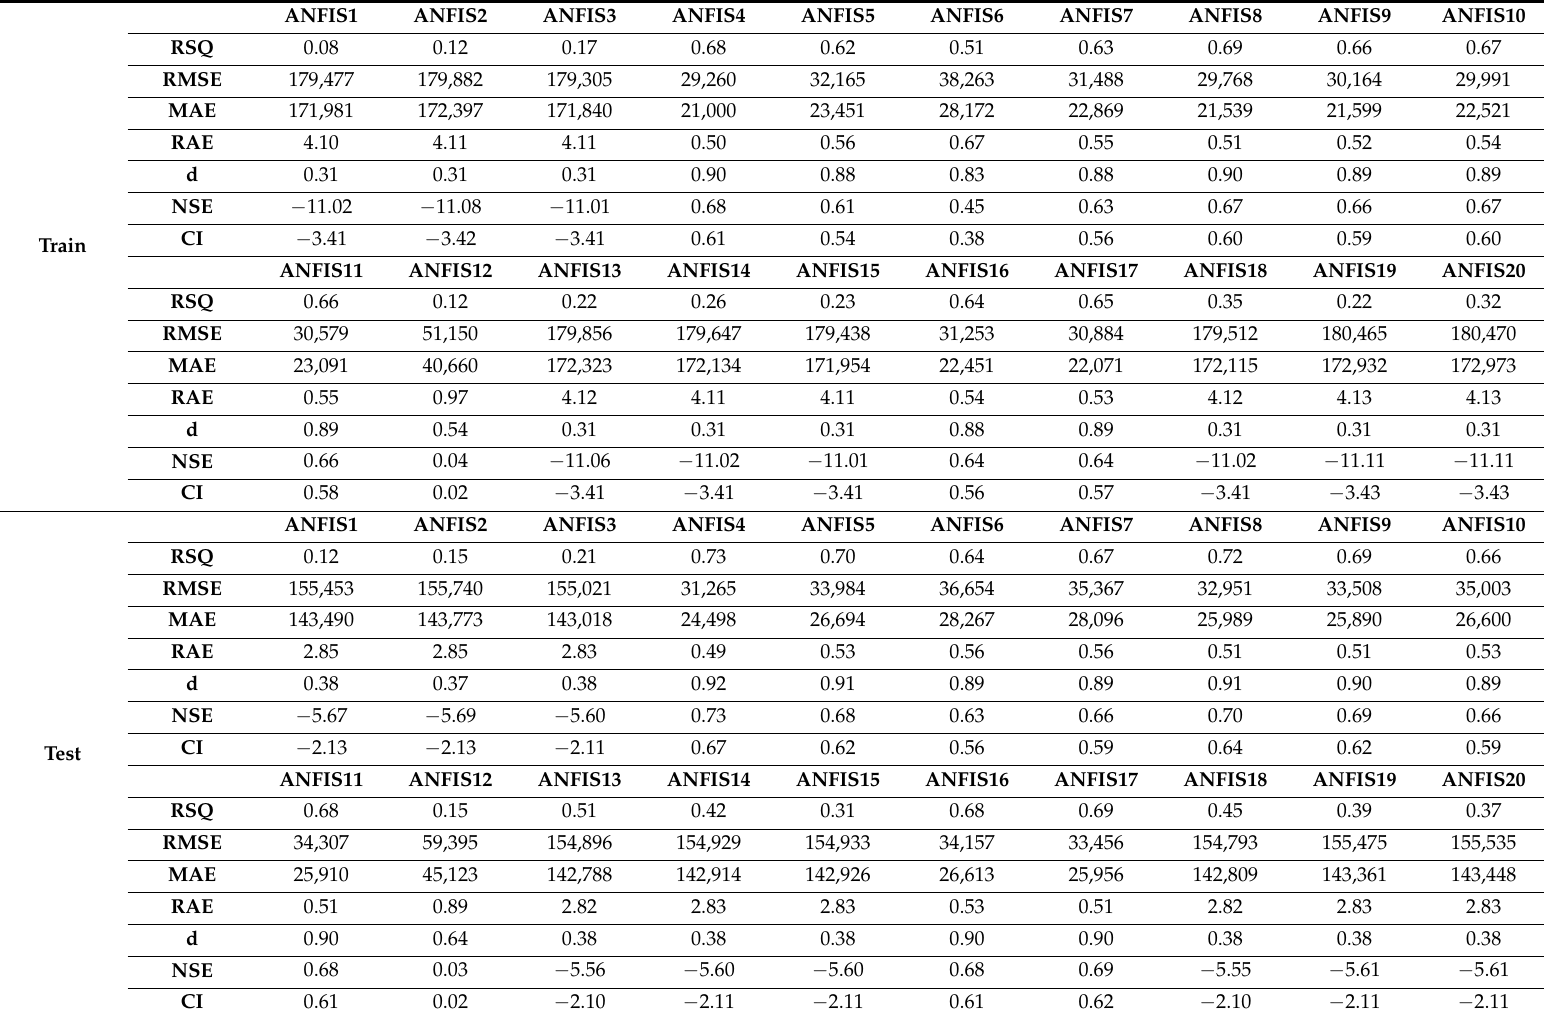
Table 4. Results of ANFIS modeling in train and test